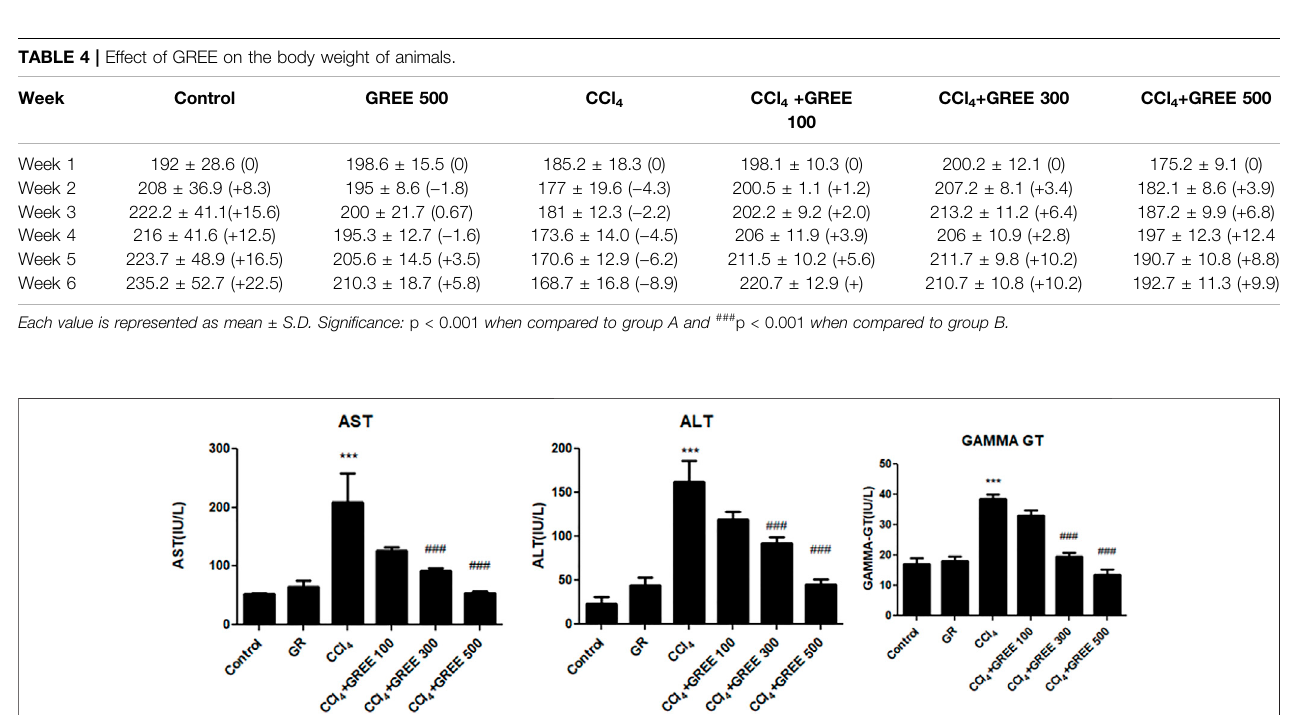
Frontiers in Pharmacology |